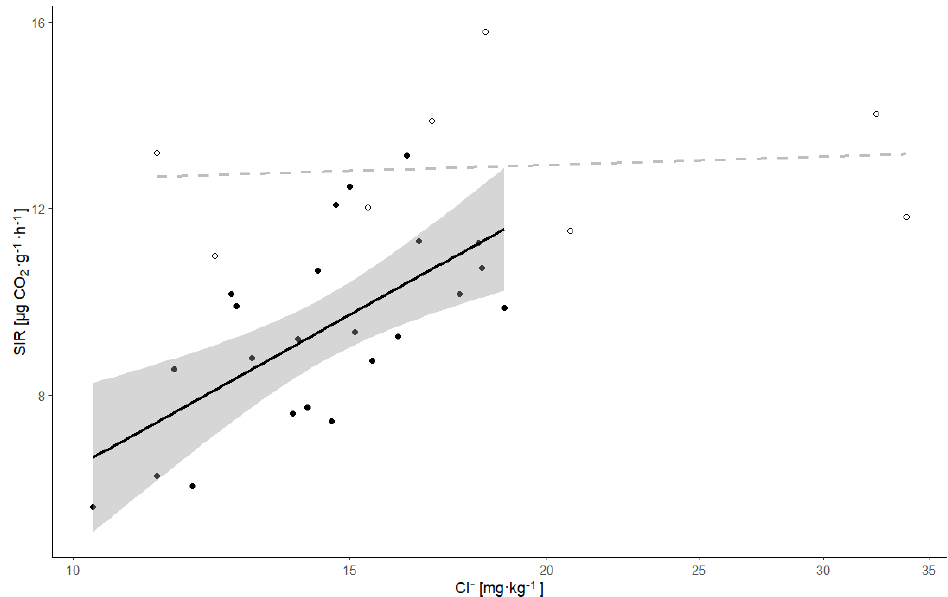
Figure 4. Linear regression models of substrate-induced respiration (SIR) as dependent on chloride contents at Placek B site, separately for the plots with different levels of C:N (full symbols + full line for C:N range 4.5–6.9; hollow symbols + dashed line for C:N range 11.2–12.7).